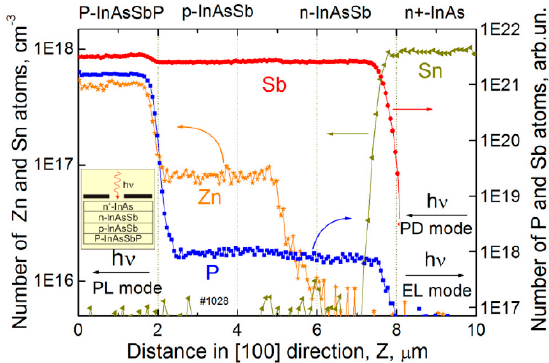
Figure 35. Distribution of P, Zn, Sn, and Sb atoms along the growth direction (SIMS data) of LPE-grown P-InAsSbP(Zn) / p-InAs 0.88 Sb 0.12 (Zn) / n-InAs 0.88 Sb 0.12 / n + -InAs(Sn) DH photodiode. Arrows on the right and left denote photon flux with respect to heterostructure layers at the photoluminescence (PL), photodiode (PD), and electroluminescence (EL) modes (after [125]).